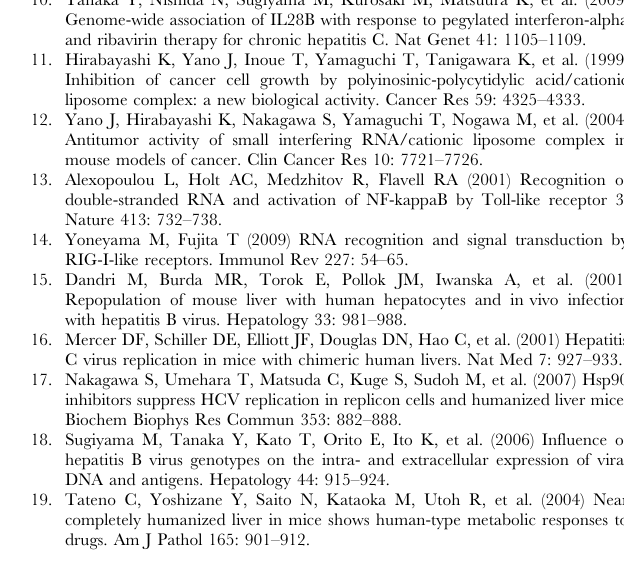
Figure S11 The expression of mouse IFN genes and corresponding receptors in chimeric mice with human- ized livers. ( A ) The liver mRNA levels of mouse IFN-encoding genes ( Ifnl2 ( Il28a ), Ifnl3 ( Il28b ), and Ifnb1 ) ( n =3–5 per group). ( B , C , D ) The liver mRNA levels of human and mouse IFN receptor- encoding genes (mouse/human genes are IFNAR1 / Ifnar1, IF- NAR2/Ifnar2 , and IFNLR1 / Ifnlr1 ( IL28RA / Il28ra ), respectively) ( n = 8–9 per group) in uninfected chimeric mice (HCV-) and in chimeric mice infected with HCV genotype 1a (HCV + ). Bars indicate SD. P -values were determined using unpaired t -tests. Text S1 Supporting materials, methods, and